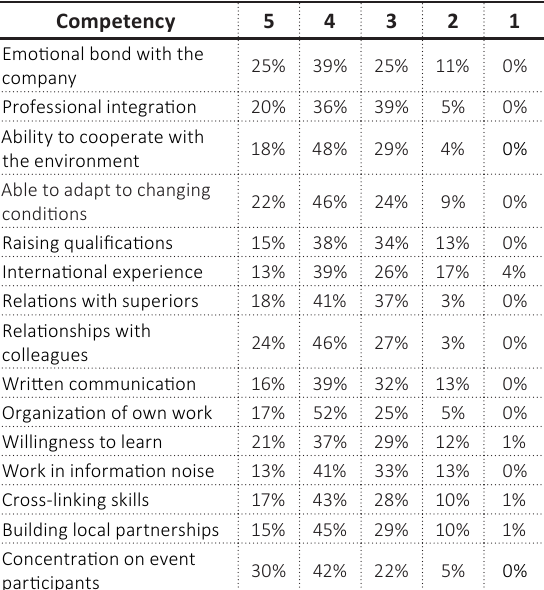
Table 4 (cont.). Social competencies of the enterprise